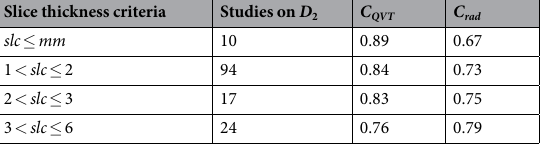
Table 1. A breakdown of the AUC performance of the C QVT and C rad classifiers as a function of CT slice thickness for the cases in D 2